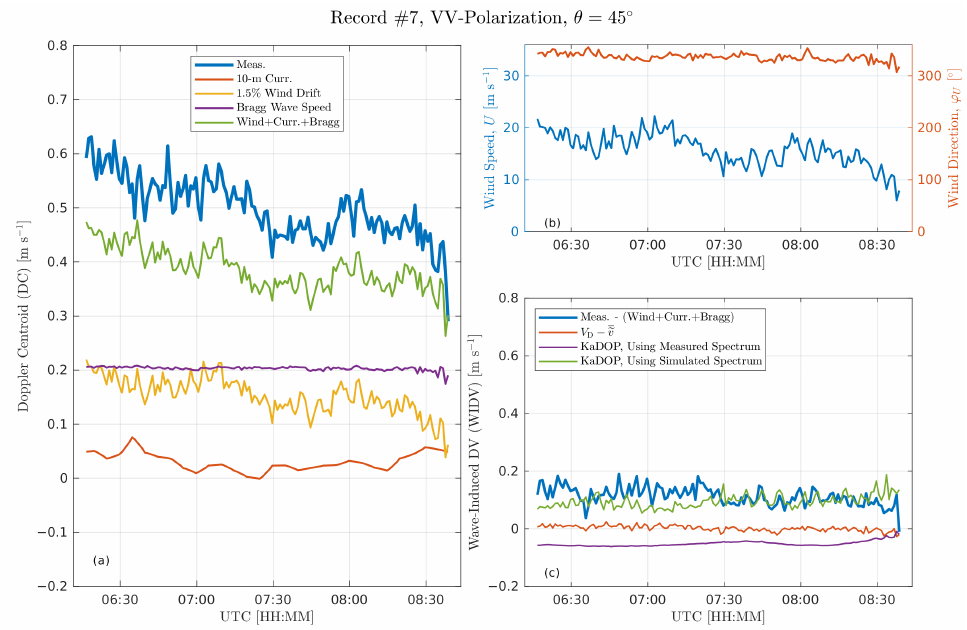
Figure 13. The same as Figure 11 but for Record #7 (5 October 2018, θ = 45 ◦ , see Figure